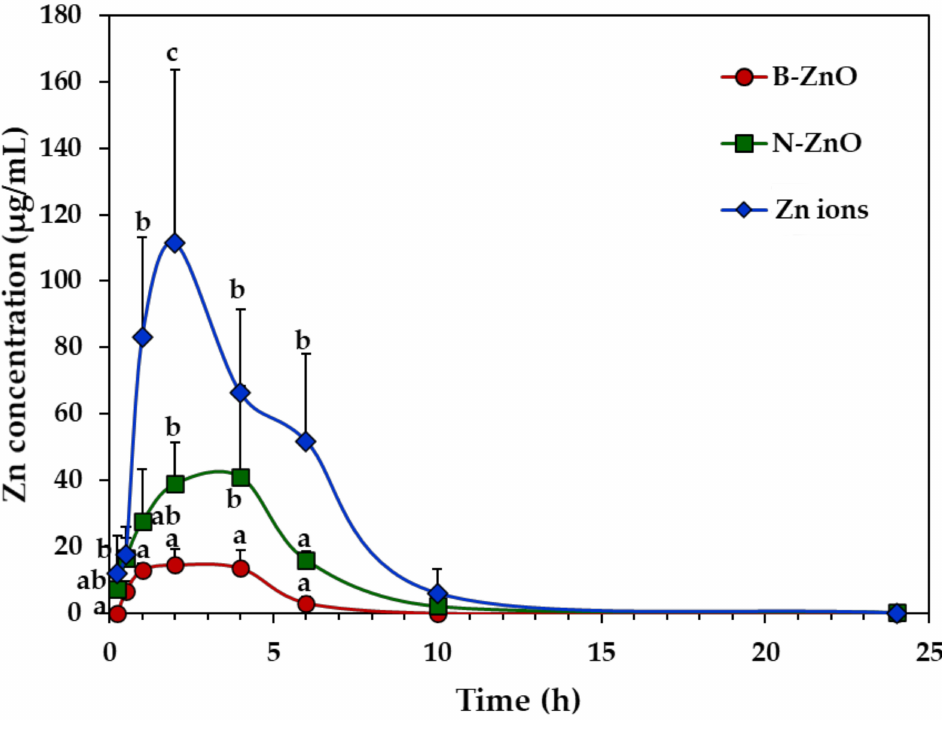
Figure 2. Plasma concentration–time profiles after a single-dose oral administration of B-ZnO, N-ZnO or Zn ions in rats. a, b, and c indicate significant differences among B-ZnO, N-ZnO, and Zn ions ( p < 0.05). Table 2. Toxicokinetic parameters and oral absorption after a single-dose oral administration of B-ZnO, N-ZnO or Zn ions in